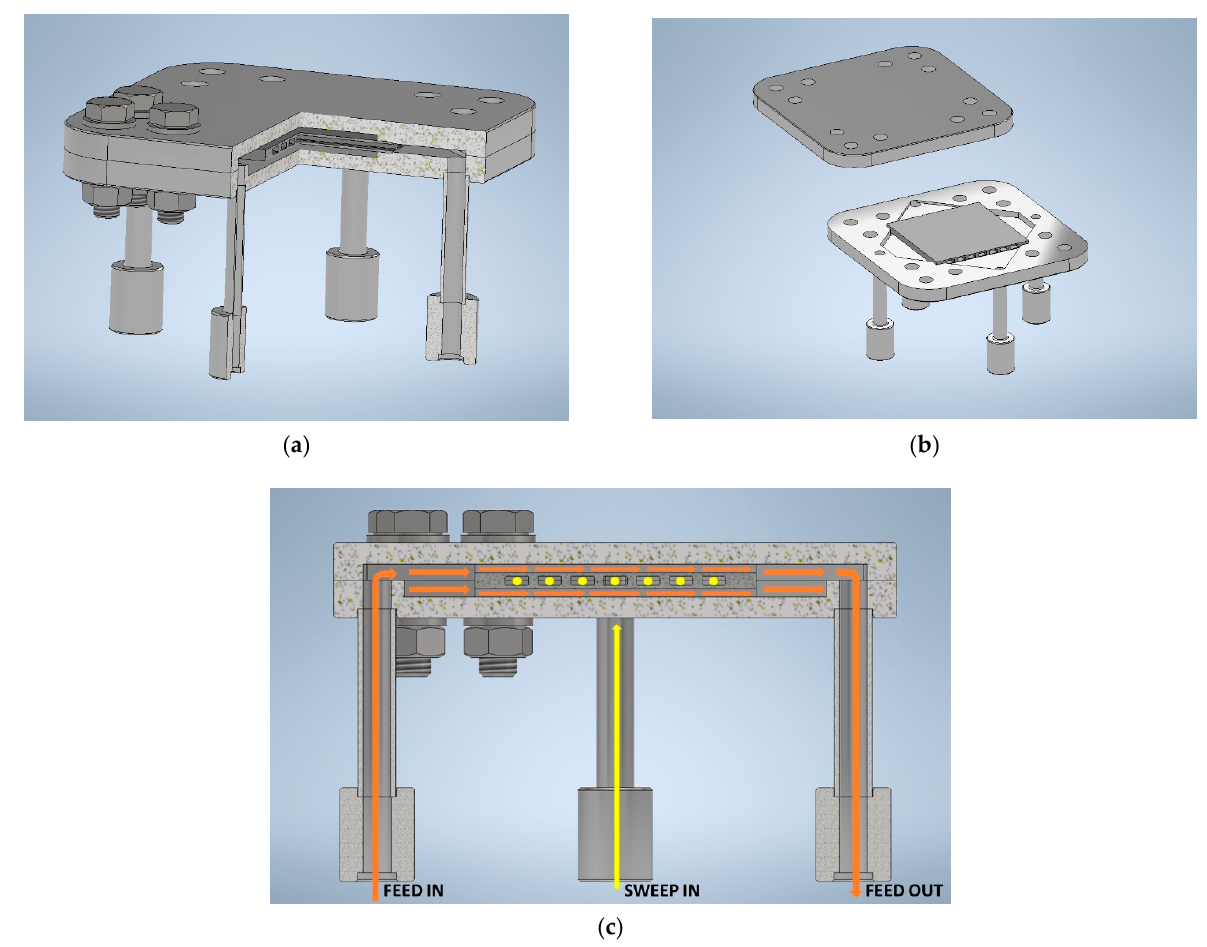
Figure 16. Drawings of the membrane component assembling in the metallic case: ( a ) section view, ( b ) open view, and ( c ) section showing the feed and sweep gas streams during operation.